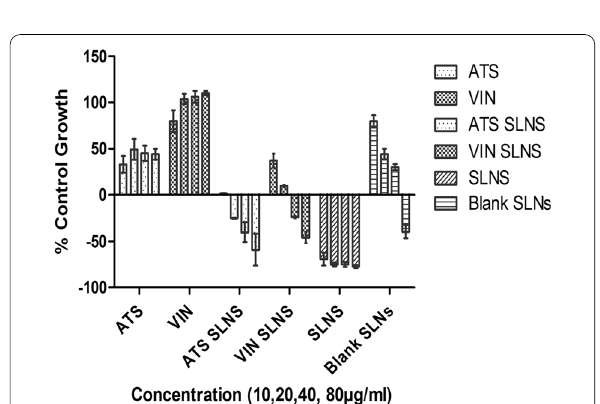
Fig. 8 Growth curve: murine skin melanoma B16 F10 cell